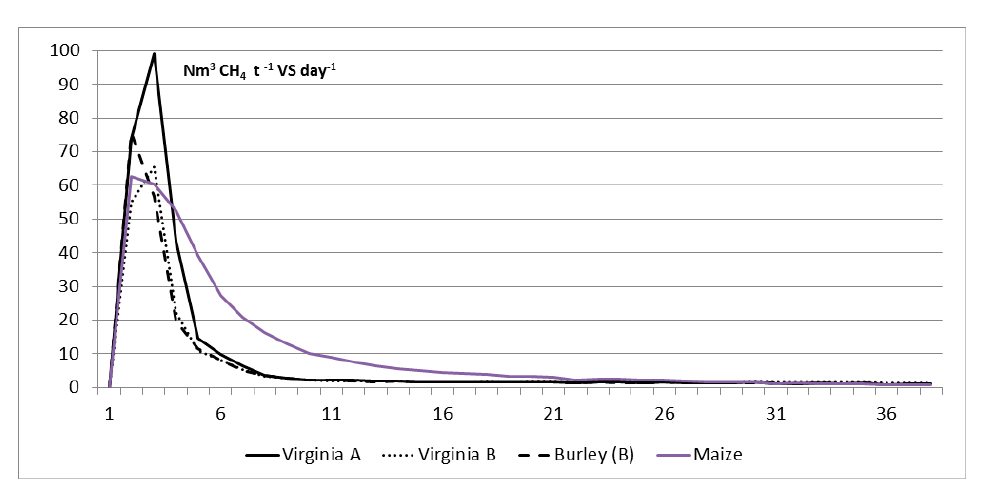
Figure 1. Daily rate of methane production from different substrates. Agriculture 2020 , 10 , x